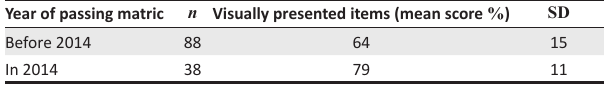
TABLE 2: Performance of students in the visually presented items in relation to pre-2014 matriculants of and the matriculants of 2014. Year of passing matric n Visually presented items (mean score % ) SD